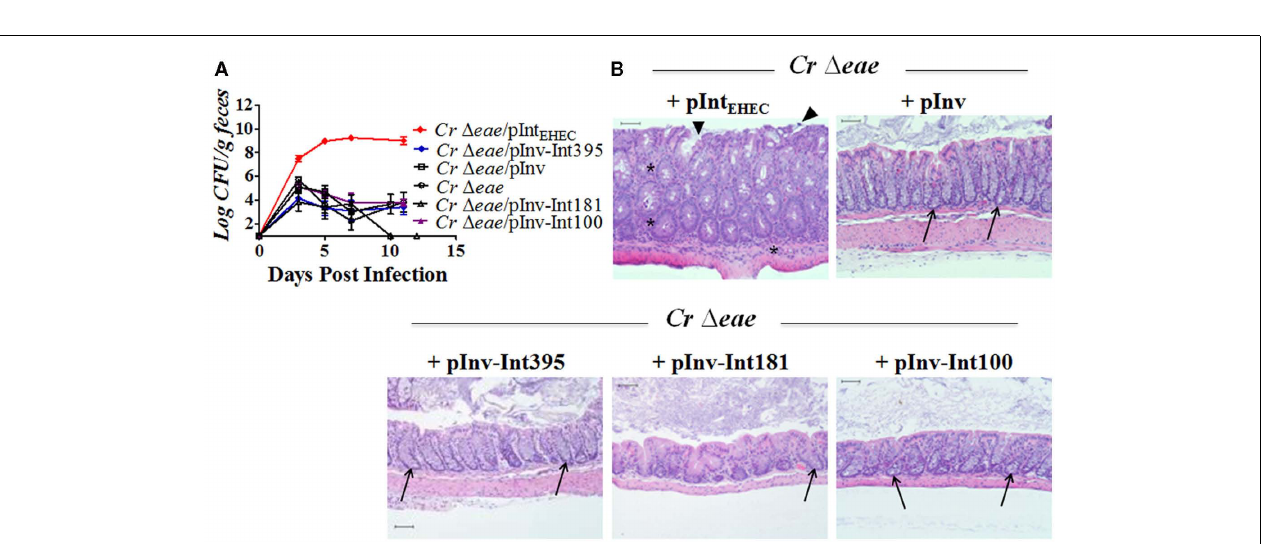
infected with C. rodentium Δ eae that hadTir foci and/or actin pedestals associated with bound bacteria, many more cells needed to be counted given the inability of this strain to adhere efficiently to cells. Data represent quadruplicate samples. Asterisk indicates that percent positive bacteria is significantly ( p < 0.05) greater than that for C. rodentium Δ eae . “#” Indicates that percent positive bacteria is significantly ( p < 0.05) lower than that for C. rodentium /pInt EHEC .